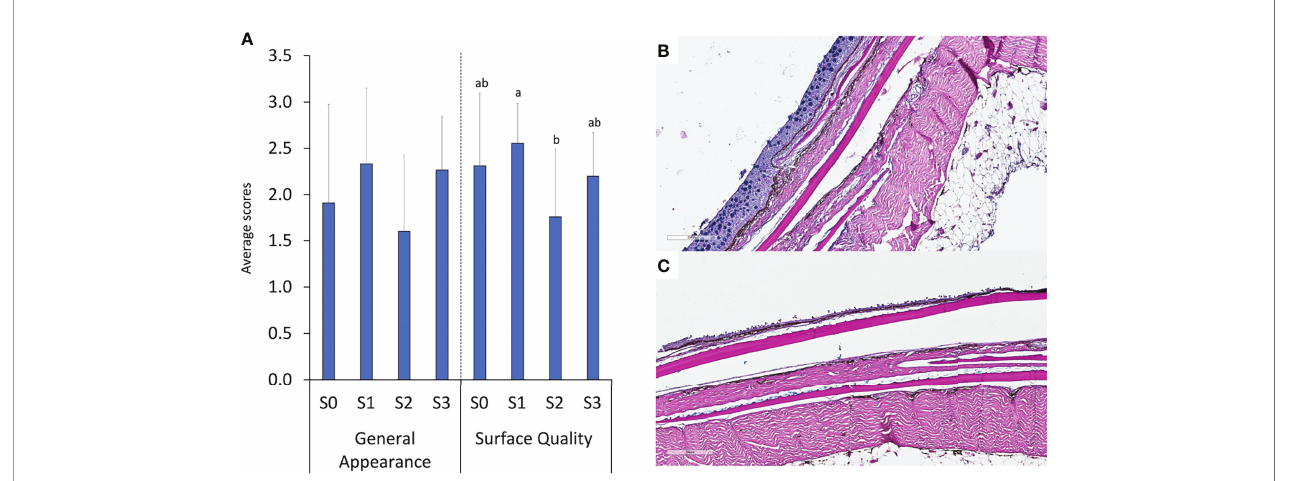
FIGURE 6 | Skin health status. (A) Histological evaluation of the skin was carried out by identifying the status of two key criteria, general appearance and surface quality, using a 0-to-3 scoring scheme. Different letters indicate a signi fi cant difference at P < 0.05. The data represent the mean ± SD of 15 individual fi sh (N=15) per sampling point. Representative histological photos of (B) healthy skin, with de fi ned epidermal and dermal layers, and (C) comprised skin, where the surface is rough and missing a signi fi cant portion of the